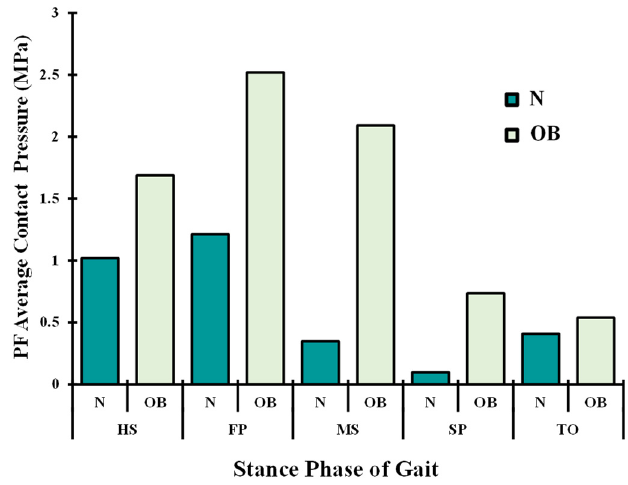
Figure 8. Predicted patellofemoral (PF) average contact pressure at different periods of stance phase time for normal (N) and obese subjects (OB).